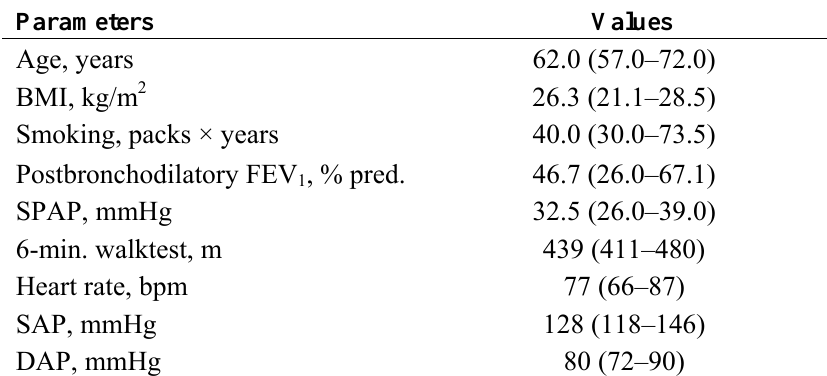
Table 1. Characteristics of patients.